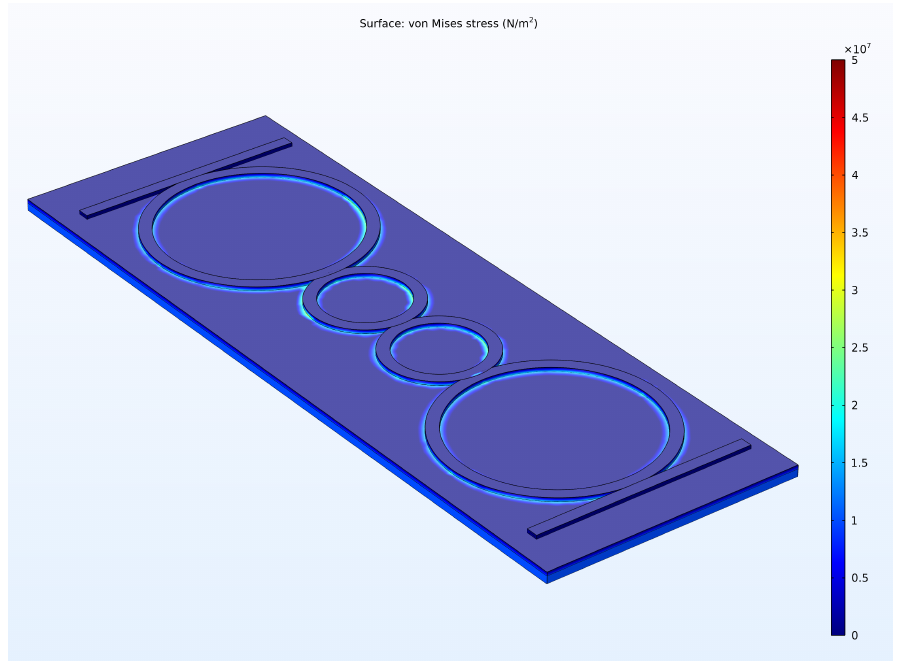
Figure 12. Von Mises stress profile. The thermal-structural deformation did not distort the funda- mental modes in the